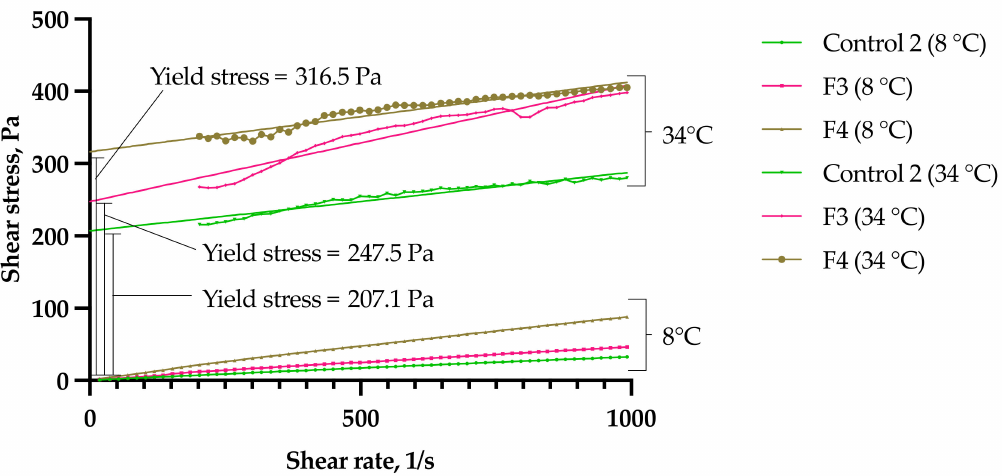
Figure 6. Flow rheogram of Control 2 and optimized sol–gels (F3 and F4) at storage temperature (8 ◦ C) and nasal temperature (34 ◦